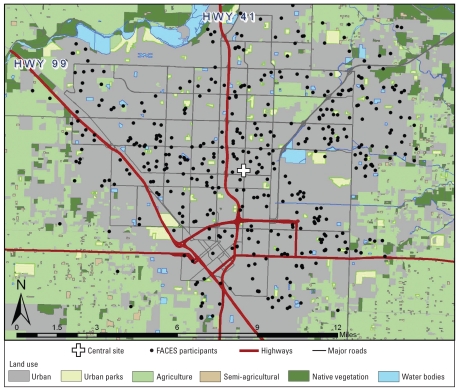
Map of study area.